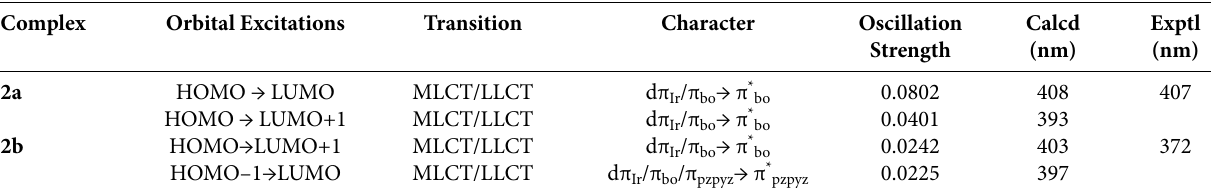
Table 3. Main experimental and calculated optical transitions for 2a–2b .